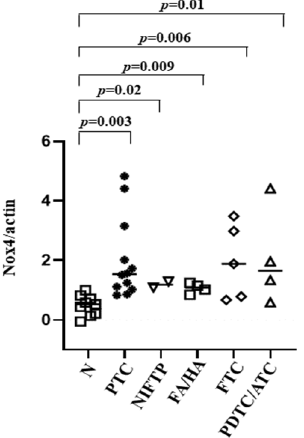
Figure 4. Normalized NOX4/ β -actin expression in thyroid tissues. N = normal contralateral tissue; PTC = papillary thyroid carcinoma; NIFTP = non-invasive follicular thyroid neoplasms with papillary-like nuclear features; FA/HA = follicular adenoma/Hurtle adenoma; FTC = follicular thyroid carcinoma; PDTC/ATC = poorly differentiated thyroid cancer/anaplastic thyroid cancer.